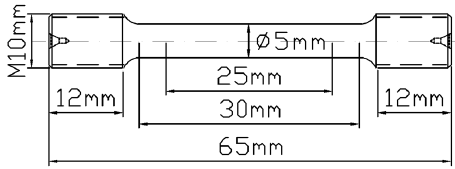
Figure 3. Sampling position of tensile specimen.